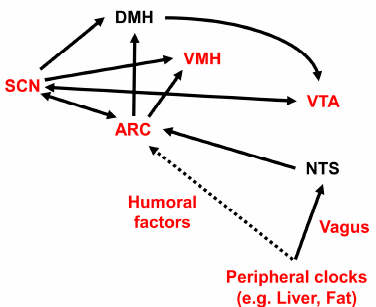
Figure 3. The high fat diet (HFD) affects neuronal nodes that are important for feeding and for the circadian system. Nodes and pathways shown in red have been reported to be affected by HFD feeding. Abbreviations: ARC, arcuate nucleus of the hypothalamus; DMH, dorsomedial nucleus of the hypothalamus; NTS, nucleus of the solitary tract; SCN, suprachiasmatic nucleus of the hypothalamus; VMH, ventromedial nucleus of the hypothalamus; VTA, ventral tegmental area.